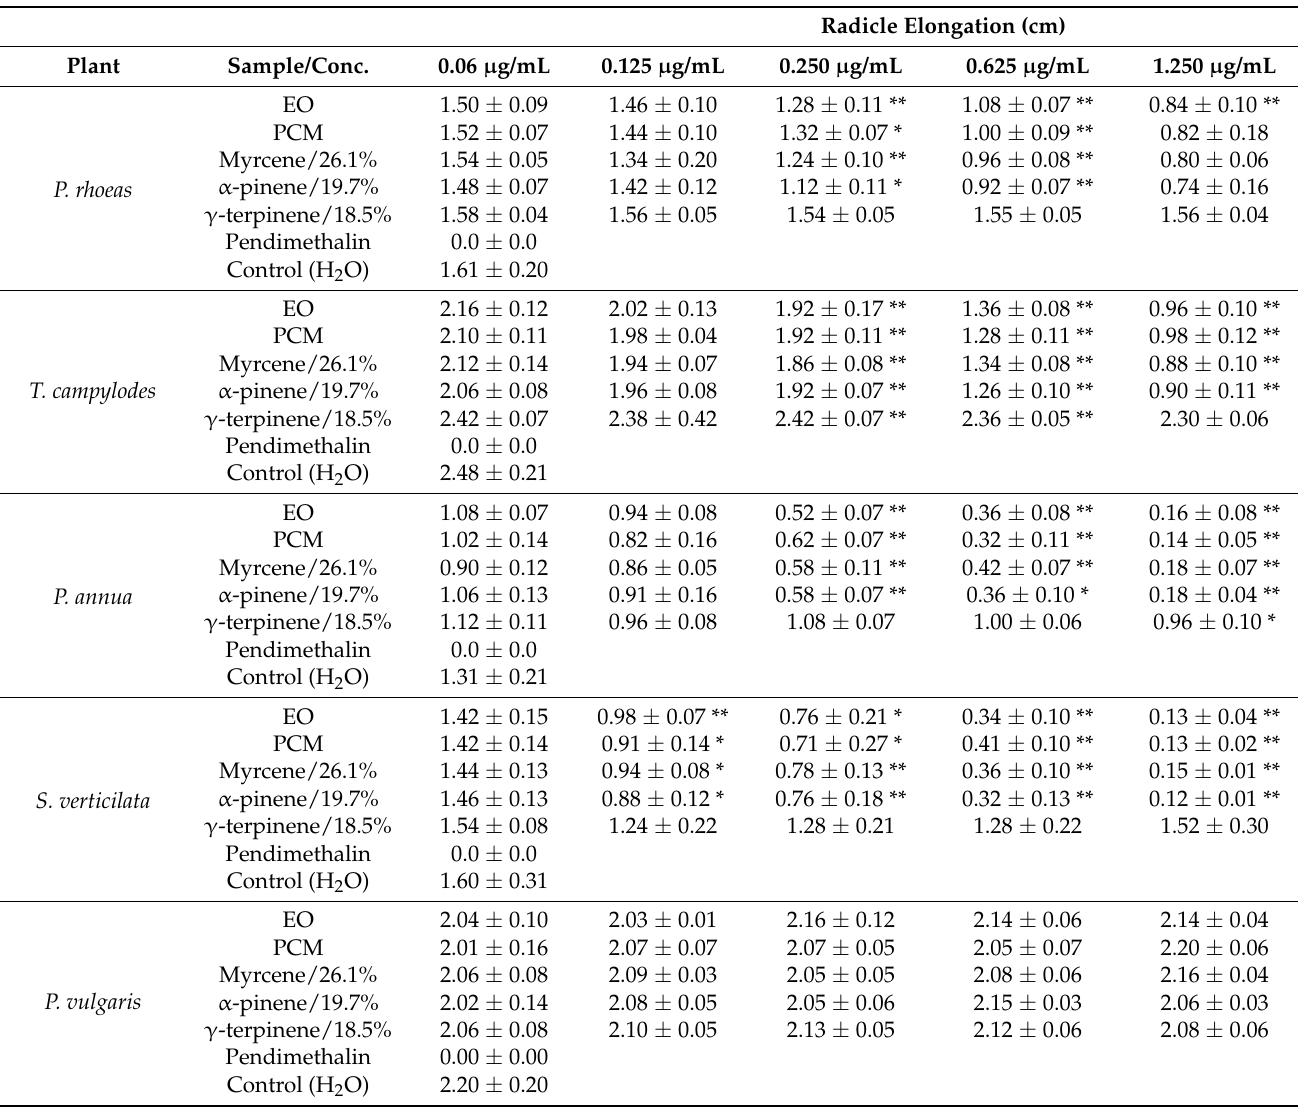
Table 3. Effect of Ferulago campestris EO, pure compounds mixture (PCM), and main EO compounds on Papaver rhoeas , Taraxacum campylodes , Poa annua , Setaria verticillata , and Phaseolus vulgaris radicle